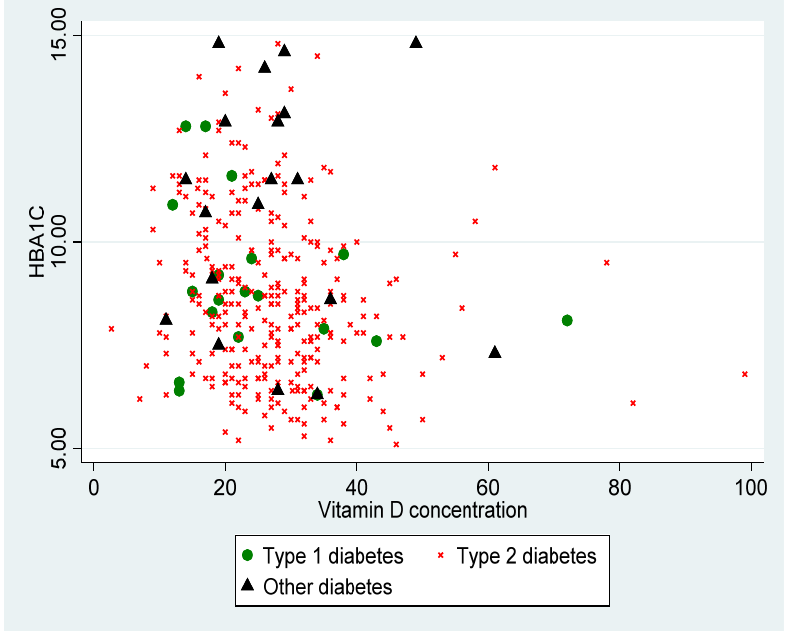
Figure 1. Distribution of HbA1c (%) according to VD (vitamin D) level in ng/mL, according to type of diabetes ( p < 0.001).